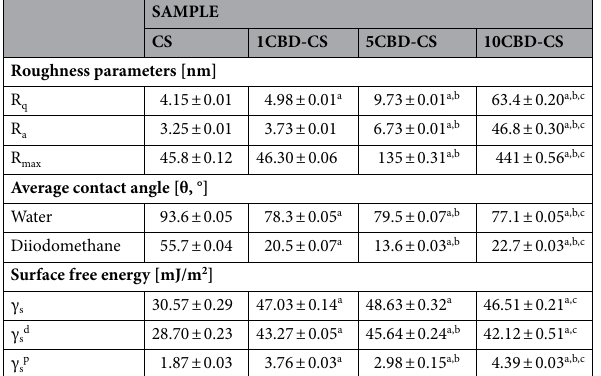
Table 2. Surface characterization of the obtained materials. CBD-CS—cannabidiol-chitosan-based films, where 1, 5, 10CBD-CS corresponds to the weight ratio of 1, 5 or 10% of cannabidiol oil (CBD) to chitosan (CS). a,b,c Indicate p < 0.05 when compared to the corresponding CS, 1CBD-CS and 5CBD-CS,